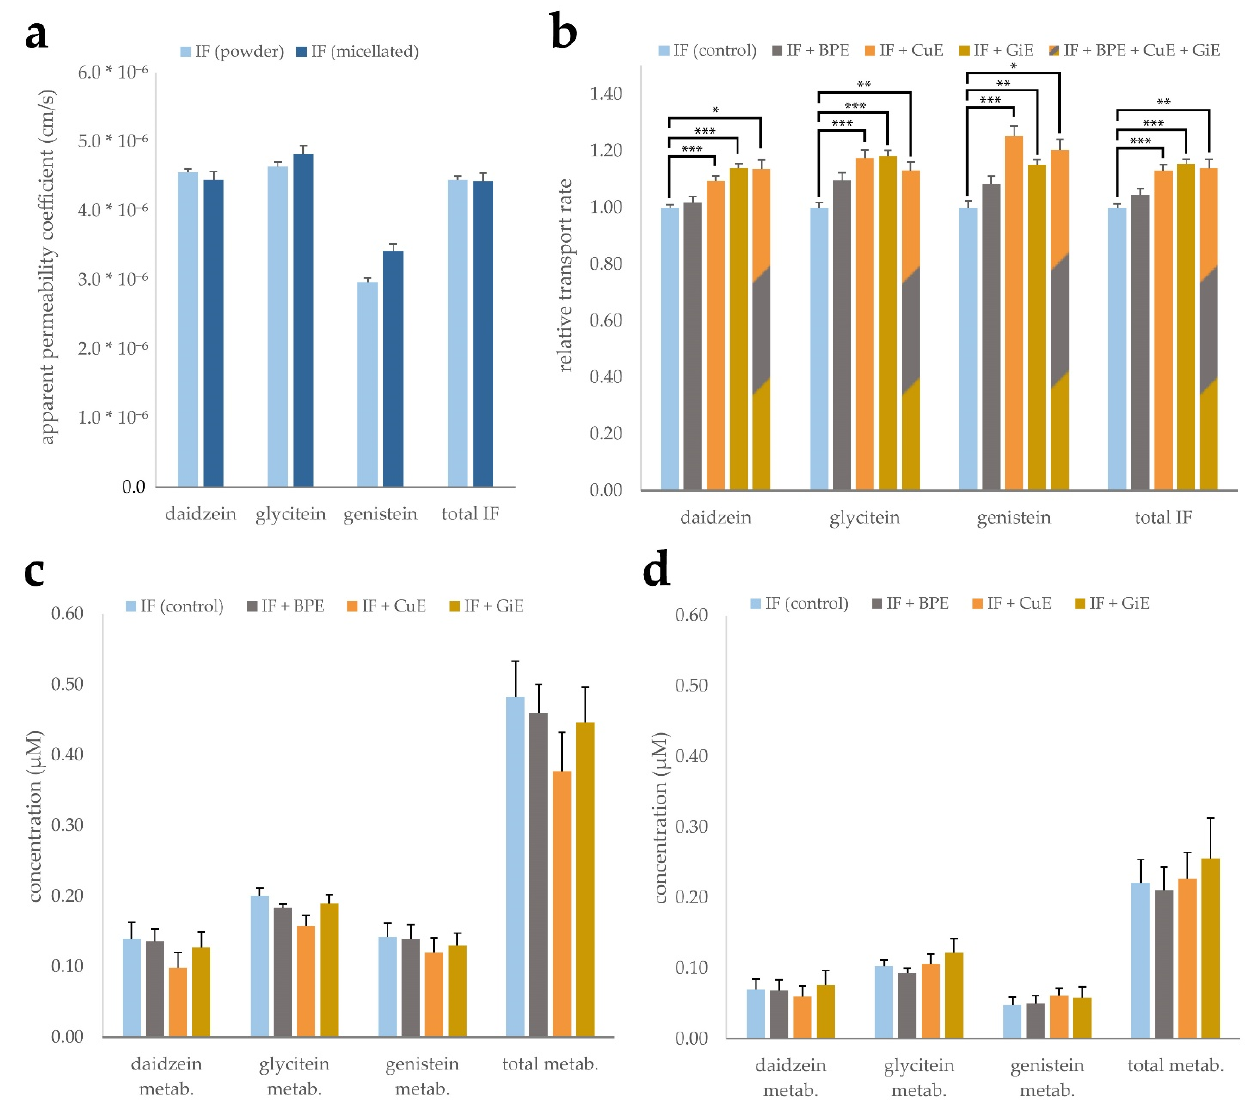
Figure 3. Transport of the isoflavones (IF) daidzein, glycitein and genistein across a CaCo-2 monolayer. Micellated and CD-complexed isoflavone products were normalized to a total content of 8.5 µ g/mL and applied after β -glucosidase digestion. Apparent permeability coefficients were calculated after determination of the concentrations in the basolateral compartment after 4 h incubation and are depicted for each aglycone individually as well as for the sum of isoflavones (total IF) ( a ). Effects of BPE, GiE and CuE were evaluated in both formulations individually and are depicted jointly by calculation of the transport rate relative to the respective control ( b ). Isoflavone metabolite concentrations in the apical ( c ) and basolateral ( d ) compartments based on determination by β‐ glucuronidase digestion. Error bars represent mean ± SEM ( n = 6). Statistically significant differences are denoted as * ( p ≤ 0.05), ** ( ≤ 0.01) and *** ( ≤ 0.001). Corresponding raw data are available in Supplementary Table